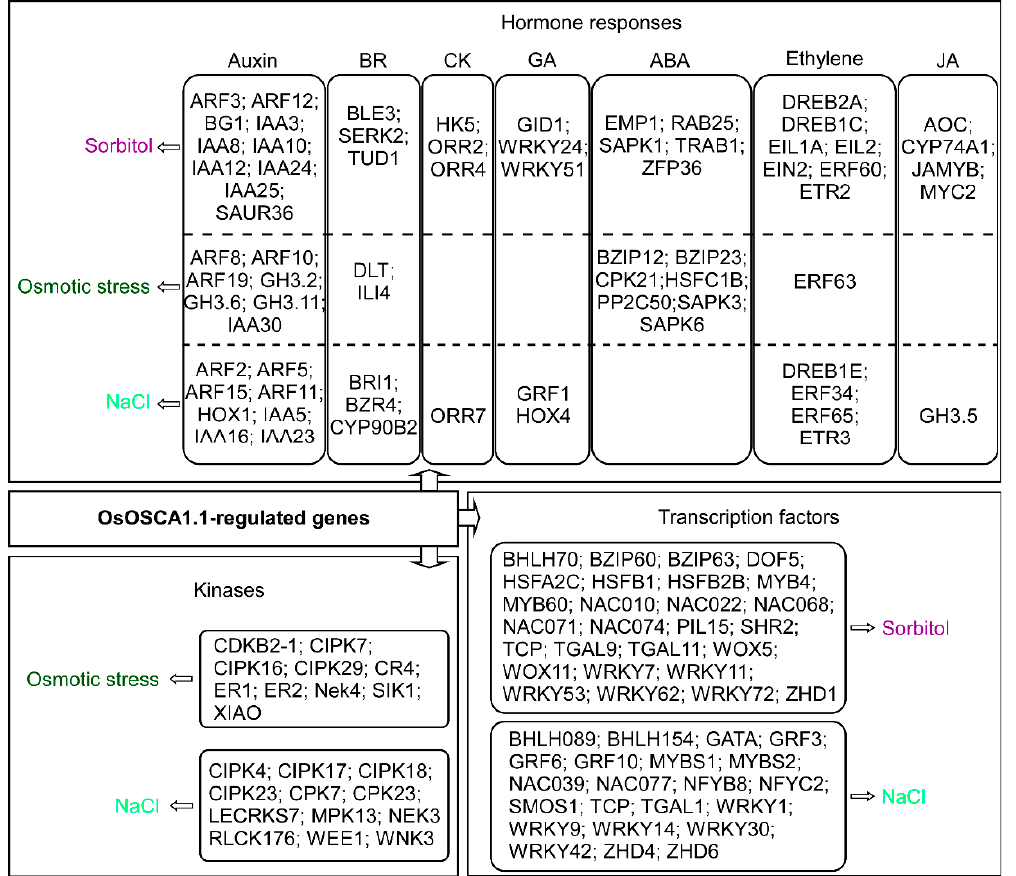
Figure 4. OsOSCA1.1-regulated genes enriched in hormone responses, gene transcriptional regula- tion, and kinases related to sorbitol stress (purple), osmotic stress (dark green), and NaCl stress (light green). The FPKM values of the listed genes are shown in Supplementary Table S3.